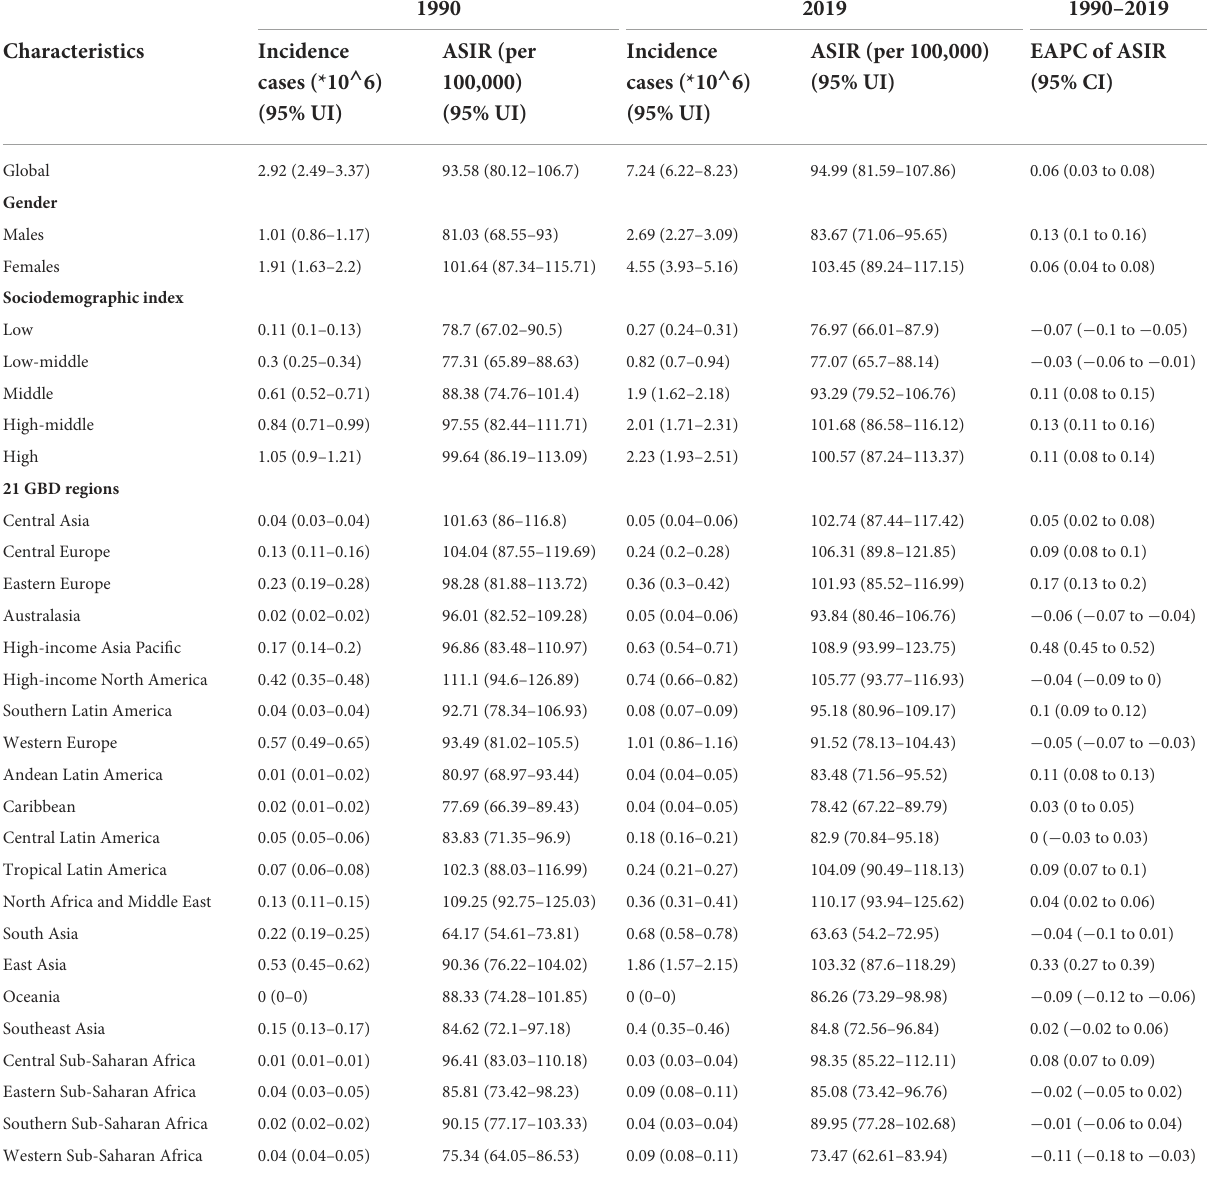
TABLE 1 The number of incidence cases and ASIR of Alzheimer’s disease and other dementias in 1990 and 2019 and its